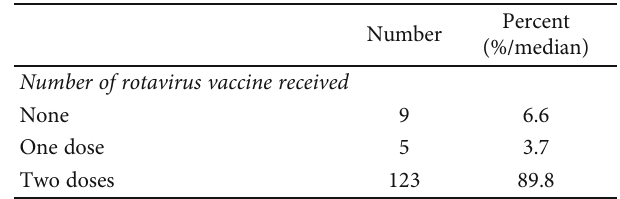
Table 1: Sociodemographic characteristics of the study participants ( n = 137